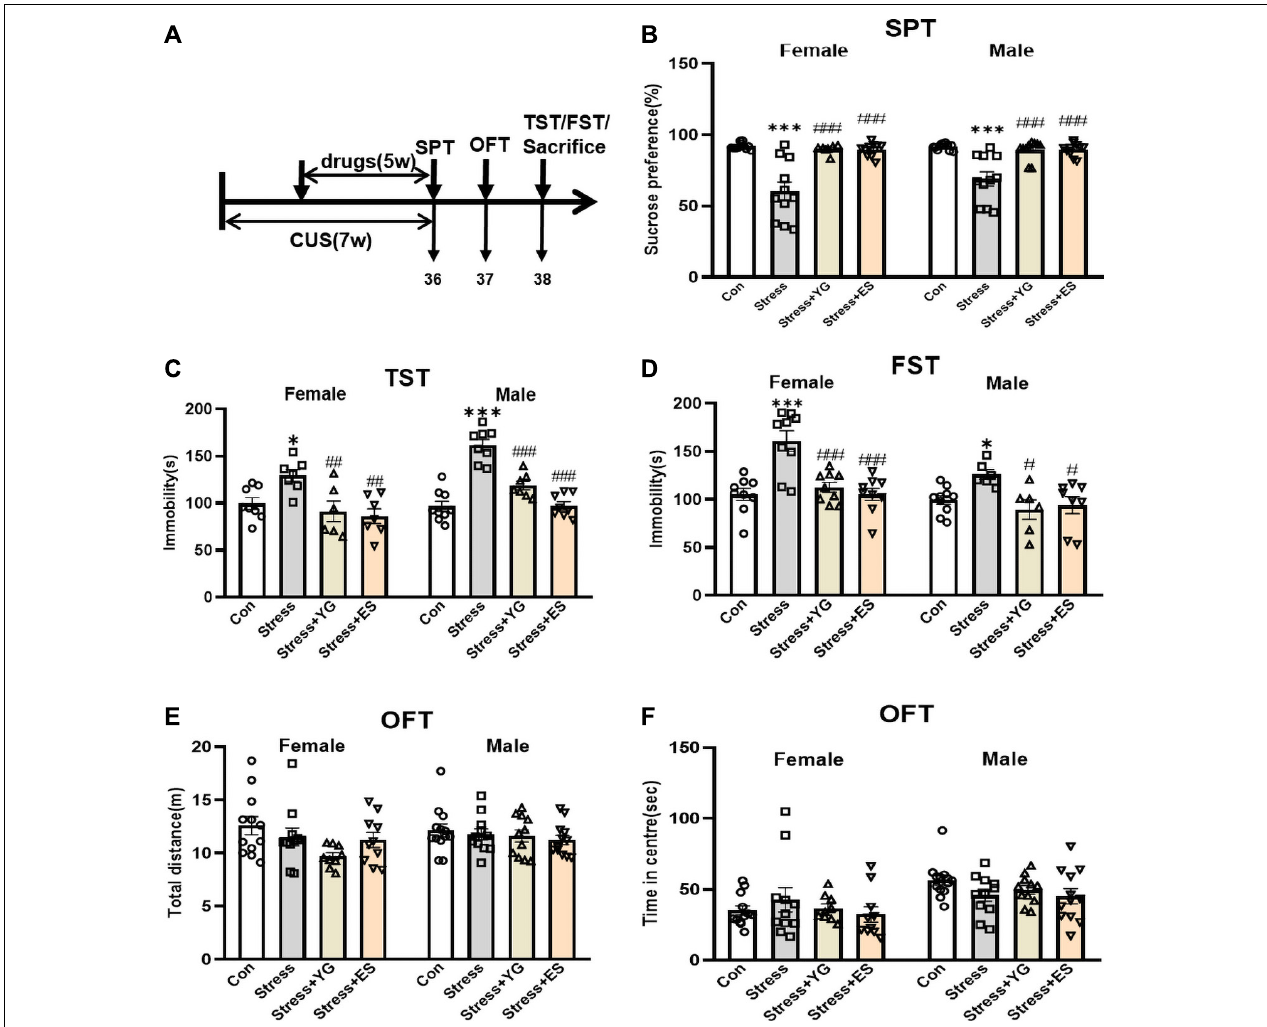
FIGURE 3 | Antidepressant-like behaviors following chronic YG or ES in CUS mice. (A) Mice were exposed to chronic unpredictable stress (CUS) and received treatment of YG or ES. Control (Con) mice were not exposed to stress but received saline treatment. Behaviors were tested after the last drug administration. (B) Mice were tested in the SPT after the last drug administration. (C) Mice were tested in the TST in 2 days after the last drug administration. (D) Mice were tested in the FST in 2 days after the last drug administration. Mice were tested in the OFT in 1 day after the last drug administration: (E) total distance and (F) time in the center. ∗ p < 0.05, ∗∗∗ p < 0.001, compared with the control group; # p < 0.05, ## p < 0.01, ### p < 0.001, compared with the CUS group. One-way ANOVA, n = 6–13/group.